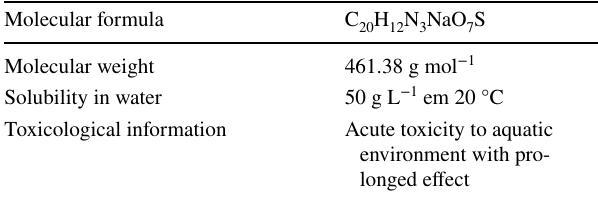
Table 1 Chemical characteristics of Eriochrome Black